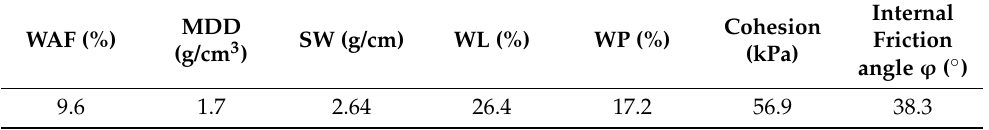
Table 2. Soil physical and mechanical properties.